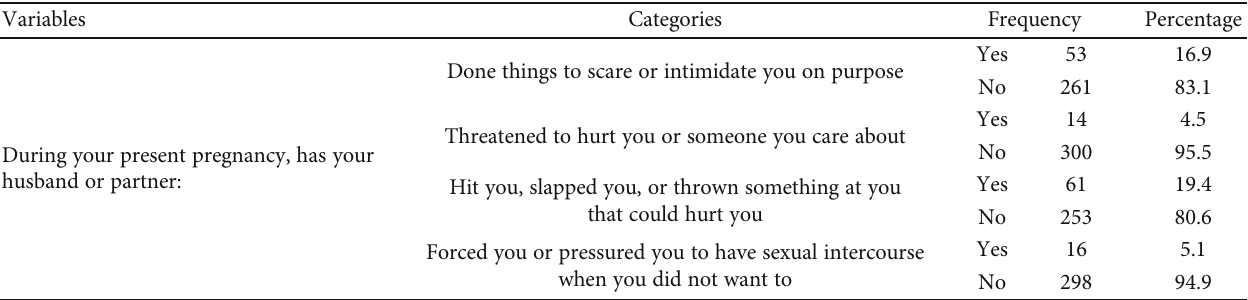
Table 5: Prevalence of antenatal depression among